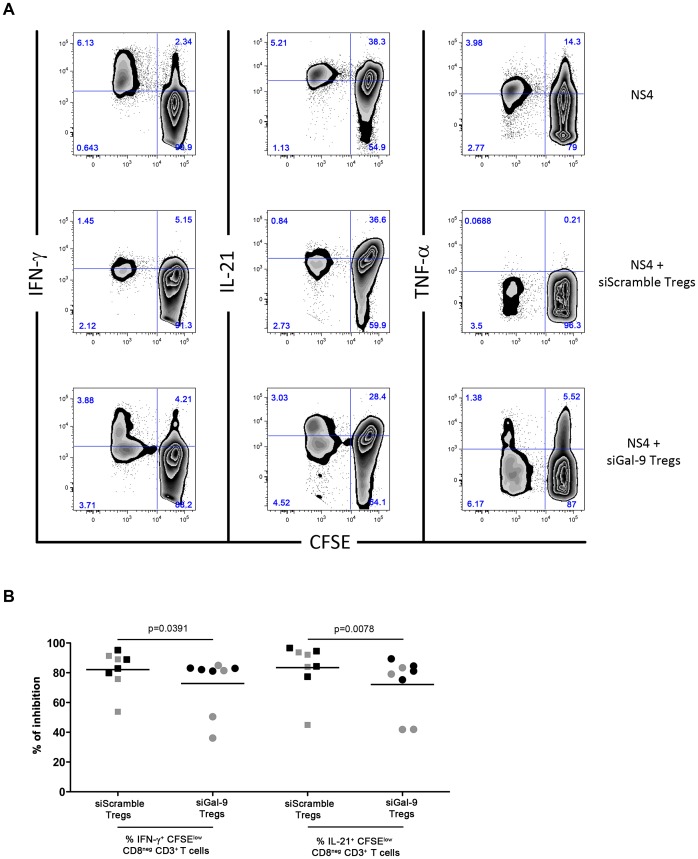
Galectin-9 knockdown limits Treg-mediated inhibition of IFN-γ and IL-21 production by HCV-specific CD4 T cells.(A) Representative combined CFSE/ICS assay demonstrating reduced Treg-mediated inhibition upon knockdown of Gal-9 by siRNA. Plots depict production of IFN-γ, IL-21 and TNF-α by HCV-specific proliferating (CFSElow) T cells in response to stimulation with recombinant HCV NS4 protein. PBMC cultures depleted of Tregs (Top panel) or with addition of Tregs (ratio 1∶4, Tregs∶CD25-depleted PBMCs) treated with either control siRNA (Middle panel) or LGALS9 siRNA were stimulated as described in Materials and Methods. Plots are gated on CD3+ CD8neg lymphocytes. (B) Percentage of Treg-mediated inhibition of IFN-γ and IL-21 production by HCV-specific T cells upon stimulation with recombinant HCV proteins (NS3: black symbols or NS4: grey symbols) in the presence of Treg cells treated with either control or LGALS9 siRNA, as described in (A) and Materials and Methods. The percentage inhibition of cytokine production upon addition of Tregs to the stimulated PBMC cultures was calculated using the following formula: (% CFSElowcytokine+CD8neg T cells in absence of Tregs – % CFSElowcytokine+CD8neg T cells in presence of Tregs)/% CFSElowcytokine+CD8neg T cells in absence of Tregs×100. P-values were calculated using Wilcoxon signed rank test.